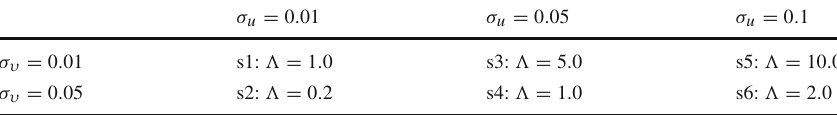
Table 1 Combinations of error and inefficiency terms in Monte Carlo simulations to model scenarios σ u = 0 . 01 σ u = 0 . 05 σ u = 0 .